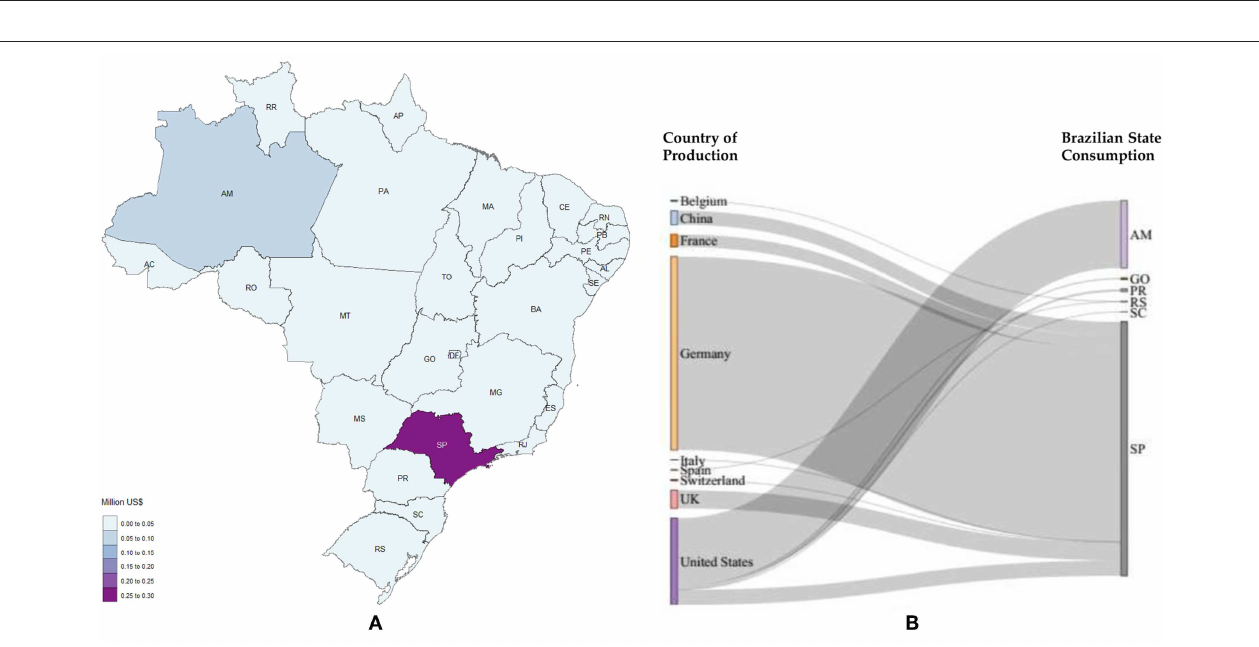
According to Figure 9 São Paulo and Amazonas are the States with the highest imports, 1.73 and 1.03 million US$, respectively. Polycarbonates were imported mainly from the United States and